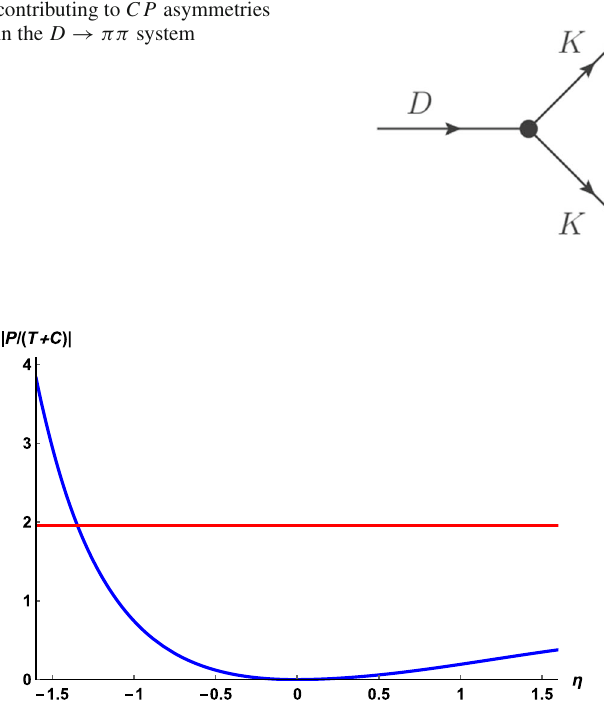
Fig. 7 Theoretical prediction for the ratio | P /( T + C ) | with η varying from − 1 . 6 ∼ 1 . 6 (blue) and t = m 2 t